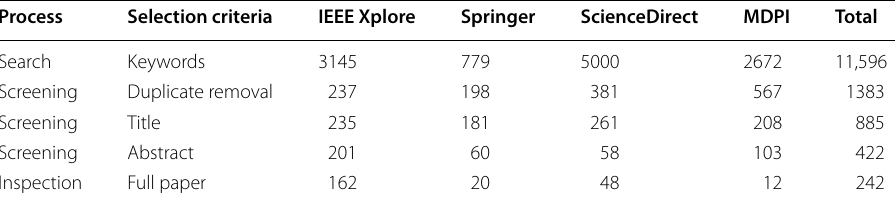
Table 3 Total numbers of papers through the selection